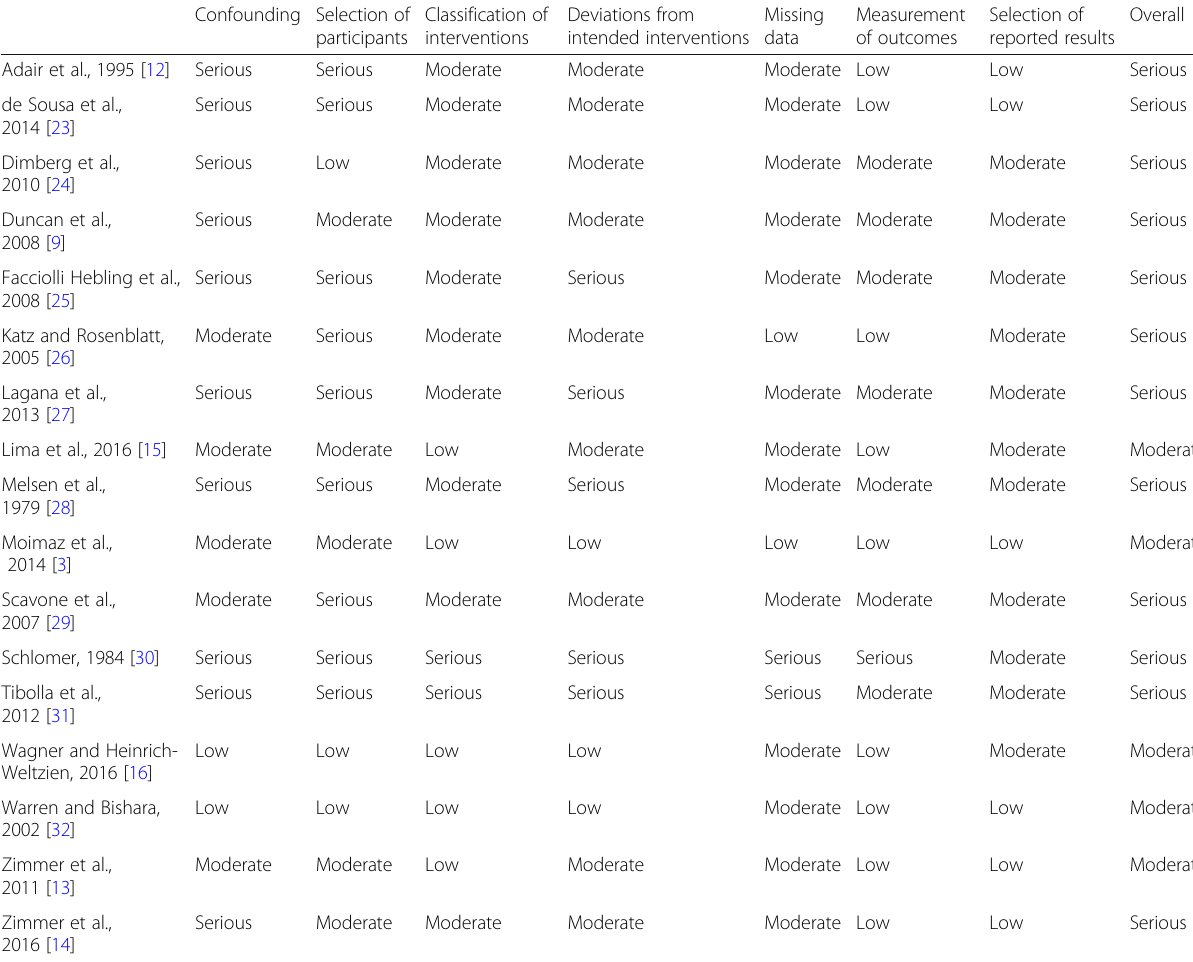
Table 2 ROBINS-I (risk of bias judgements in non-randomized studies of interventions)